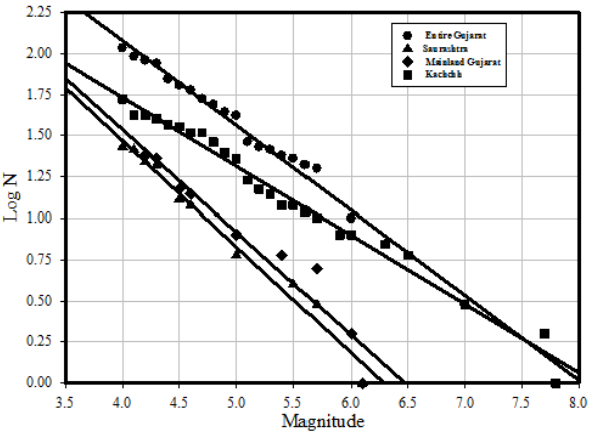
Fig. 6. Gutenberg-Richter frequency magnitude recurrence rela- tionship for Kachchh, Saurashtra, Mainland regions and the entire region of